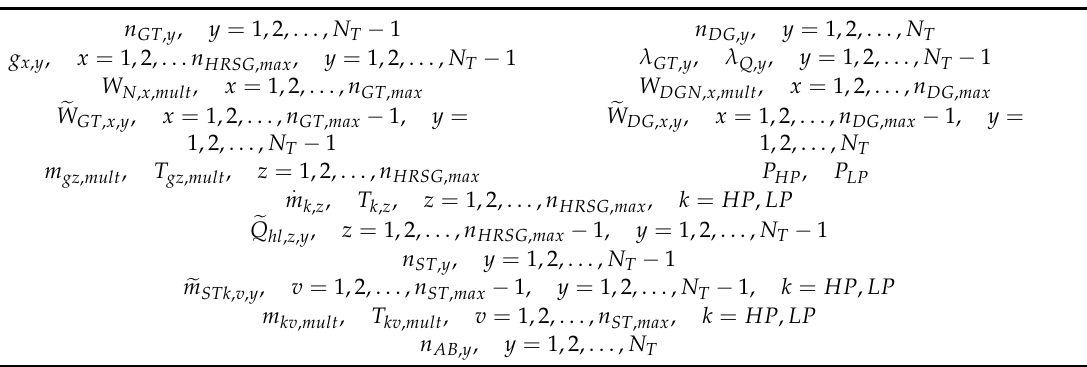
Table 1. Independent variables of the optimization